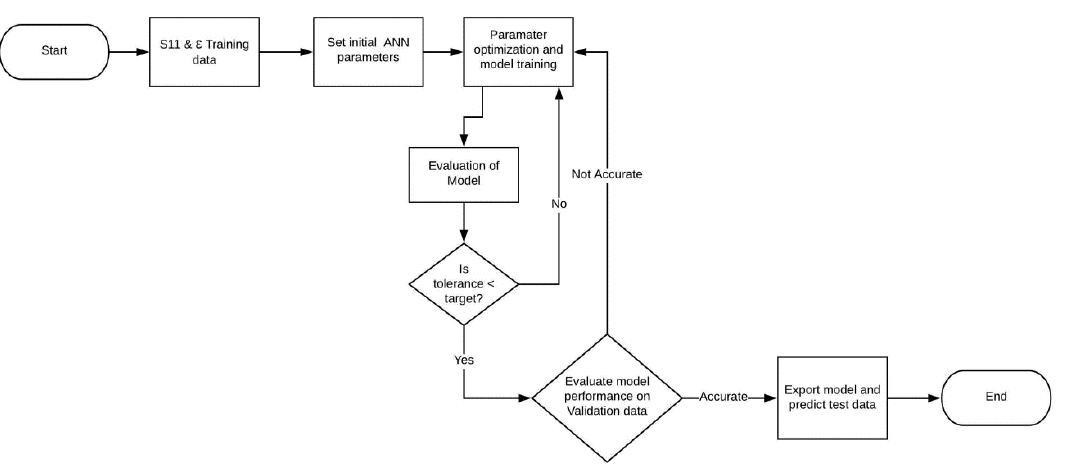
Figure 6. A schematic diagram showing training, validation and testing sequence of the ANN.